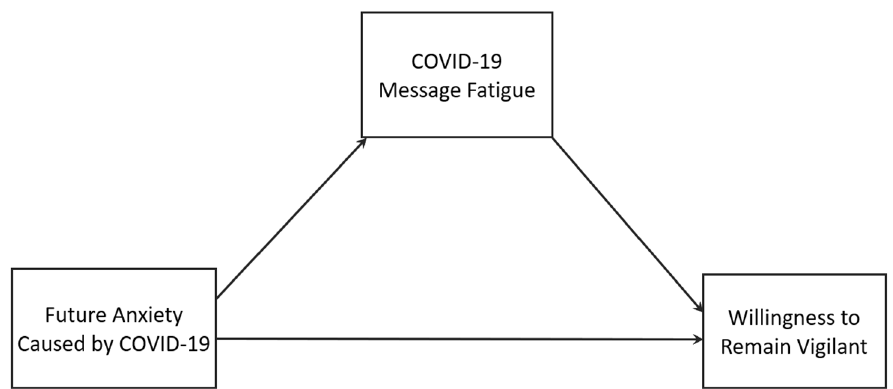
Figure 1. Illustration of the proposed mediation model.